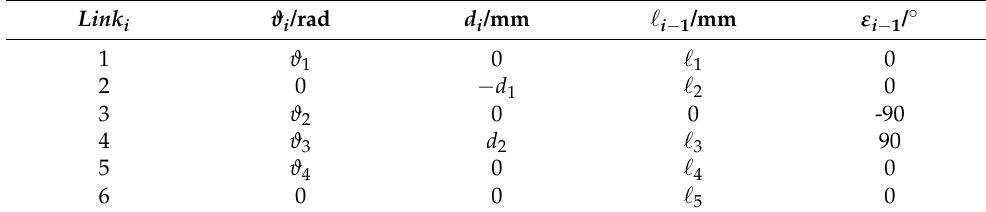
Figure 5. Coordinate system diagram of the designed WURAES. Table 1. Denavit–Hartenberg coordinate parameters of the designed WURAES.